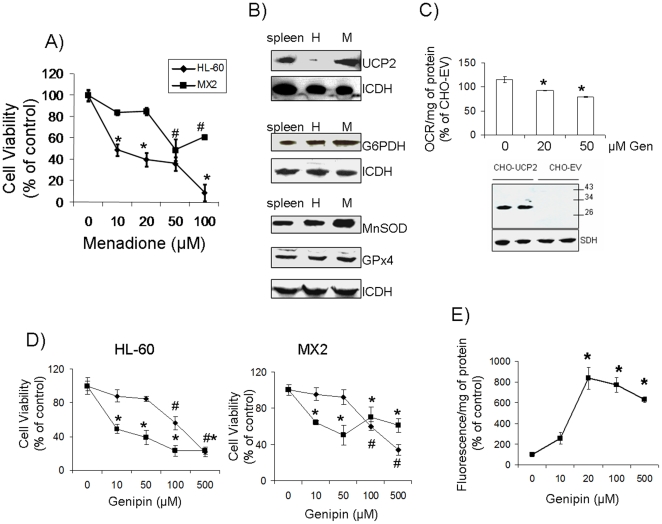
Genipin sensitizes drug-resistant MX2 cells to menadione toxicity.A) The viability of HL-60 (filled diamond) and MX2 (filled square) following exposure to menadione. Cells were exposed for 24 h to different concentrations of menadione (0–100 µmol/L) followed by the assessment of the number of live cells. Viability was expressed as a percent of the control value. Kruskall-Wallis with a post-hoc Mann-Whitney test, n = 3, p<0.05. * indicates statistical significance for HL-60 cells compared to control and # indicates statistical significance for MX2 compared to control. B) Immunoblot analysis of anti-oxidant defense enzymes and UCP2. Mitochondria from MX2 (M) and HL-60 (H) cells were isolated and analyzed for UCP2, MnSOD, and GPx4. Cytosol was used for G6PDH determinations. NADP-ICDH served as the loading control for the cytosol and mitochondrial fractions. Spleen lysate (100 µg) was used as a UCP2 loading control. The molecular weight of UCP2 was confirmed using molecular mass markers. C) In situ analysis of the specificity of genipin for UCP2. Following the determination of basal oxygen consumption rates, the impact of genipin on OCR in CHO-UCP2 (white bars) cells was assessed. Cells were exposed to (0–50 µM) genipin for 15 min and then OCR was tested. Data was expressed as a % of CHO-EV OCR. INSET: immunoblot analysis of UCP2 in CHO-UCP2 and CHO-EV cells. SDH served as the loading control. Kruskall-Wallis with a post-hoc Mann-Whitney test, n = 3, p<0.05. * indicates statistical significance when compared to the control. D) Assessment of genipin toxicity and the response of drug-sensitive HL-60 and drug-resistant MX2 cells to simultaneous treatment with menadione and genipin. Cells were exposed to genipin (0–500 µmol/L) in the presence or absence of 20 µM menadione for 24 h. Following the exposure, cell viability was determined. ♦ and ▪ represent exposure to either genipin or genipin + menadione. Viability was expressed as a percent of the control. Kruskall-Wallis with a post-hoc Mann-Whitney test, n = 3, p<0.05. * corresponds to statistical significance when cells exposed to both menadione and genipin were compared to control. # corresponds to statistical significance when genipin-exposed cells were compared to the control cells. E) Treatment with genipin and menadione increases MX2 cell death. MX2 cells were exposed to 20 µmol/L menadione and genipin (0–500 µmol/L) for 24 h. The amount of cell death was determined using the PI assay. 1-way ANOVA with a post-hoc Tukey's test, n = 5, p<0.05. * represents significance when compared to 0 µM.